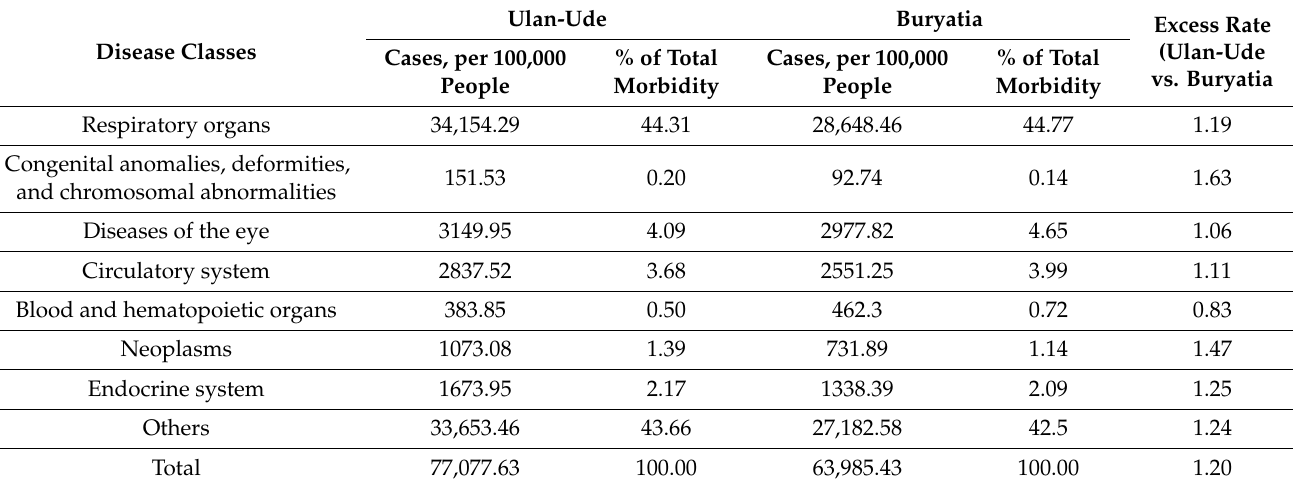
Table 5. Comparative characteristics of morbidity in Ulan-Ude and Buryatia for 2011–2020.